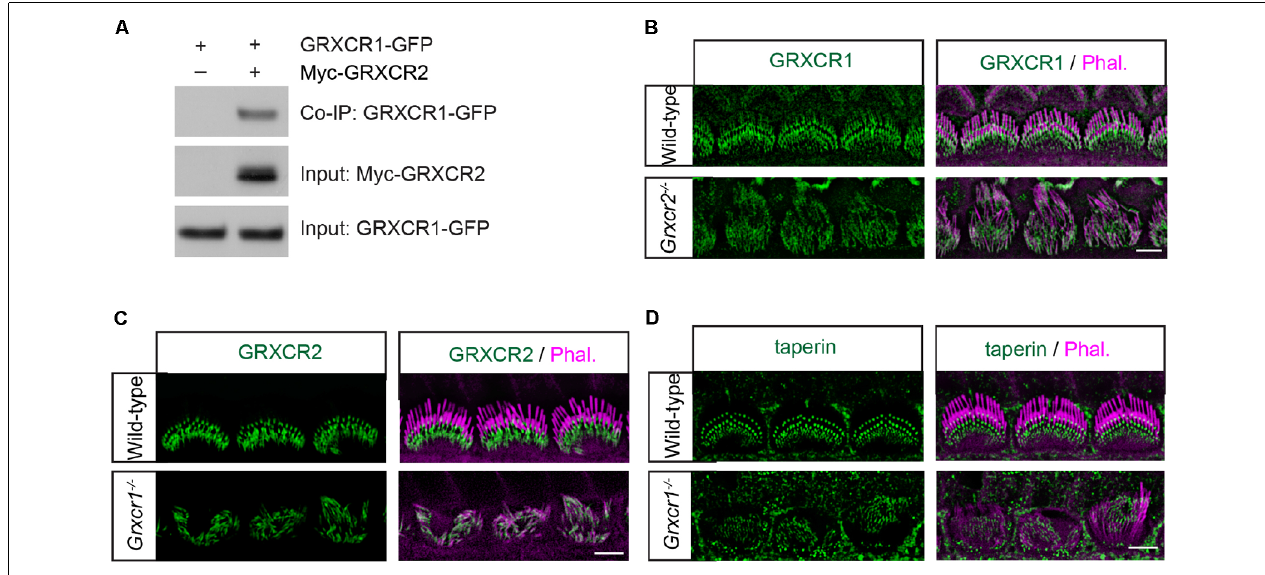
FIGURE 3 | Localization of taperin and GRXCR2 in Grxcr1 -deficient hair cells. (A) HEK293 cells were transfected with GRXCR1-GFP and Myc-GRXCR2. Immunoprecipitation was carried out with Myc-antibody. The upper row shows co-IP result and the lower rows show input proteins. (B) Cochlear whole mounts from Grxcr2 − / − mice at P7 was stained for GRXCR1. (C,D) Cochlear whole mounts from Grxcr1 − / − mice at P7 were stained for GRXCR2 (C) and taperin (D) . Scale bars: 5 µ m.